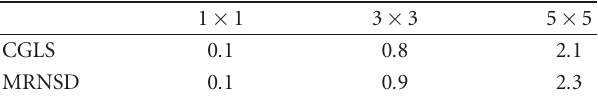
Table 1: The restoration time per iteration depending on the num- ber of image subregions. The computation time is given in seconds for an Intel PC with 1.7 GHz Pentium 4 processor and 256-MB